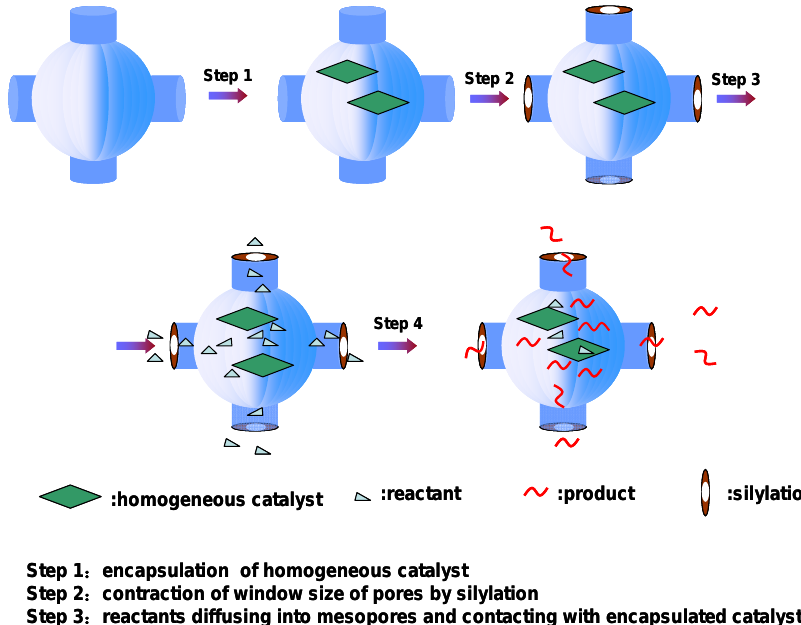
Figure 8. Schematic description of entrapping homogeneous catalyst within the cage of mesoporous silicas. Reproduced with permission from Royal Society